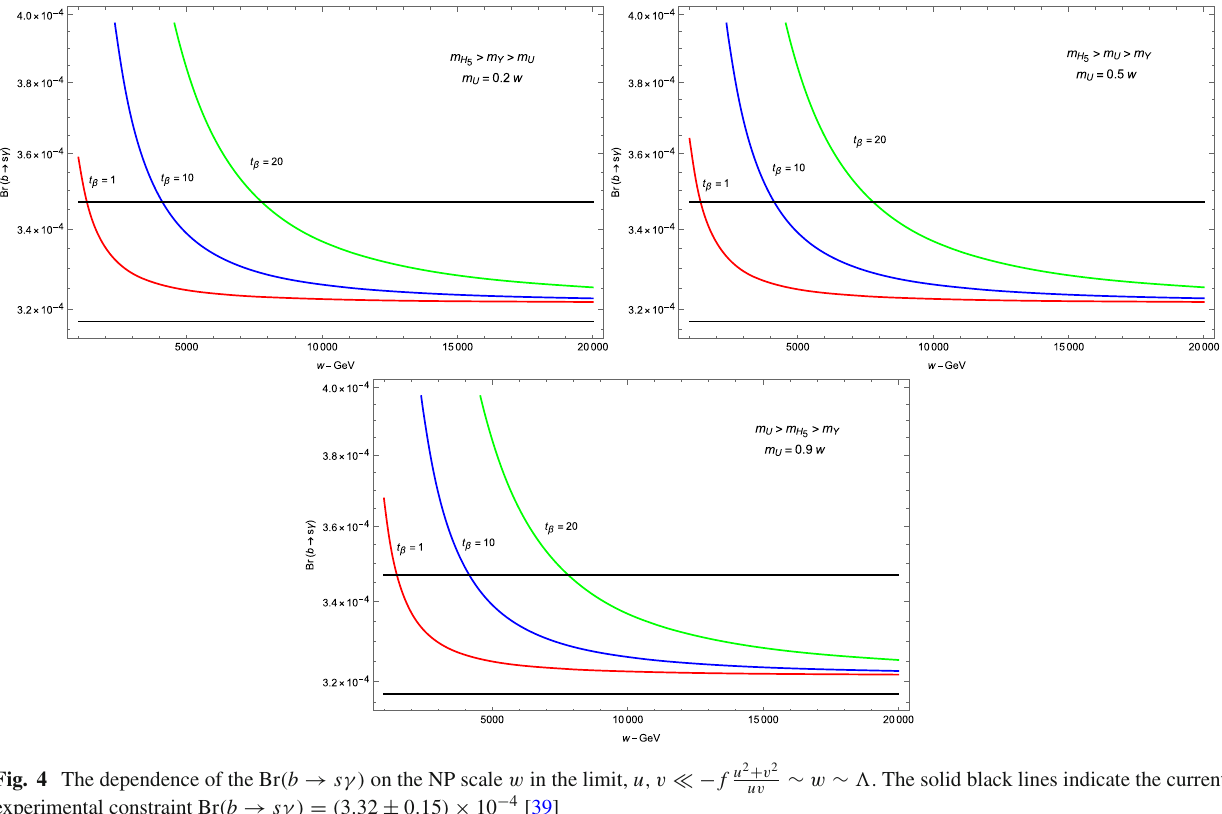
∼ w ∼ (cid:12) . The solid black lines indicate the current u v